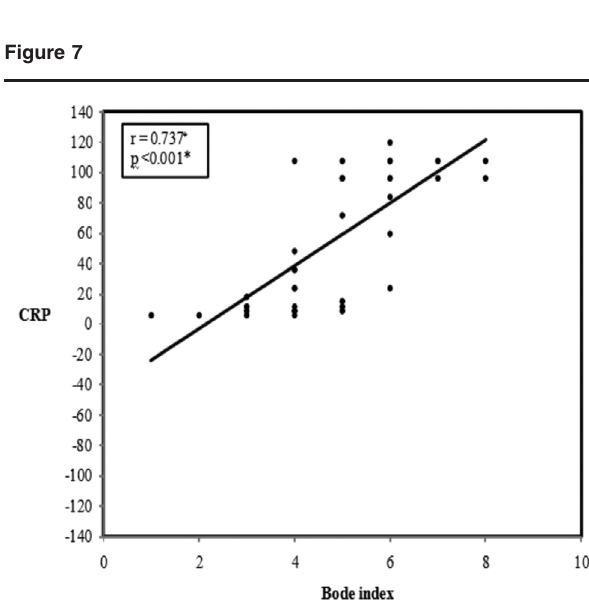
Correlation between FEV-1 predicted and